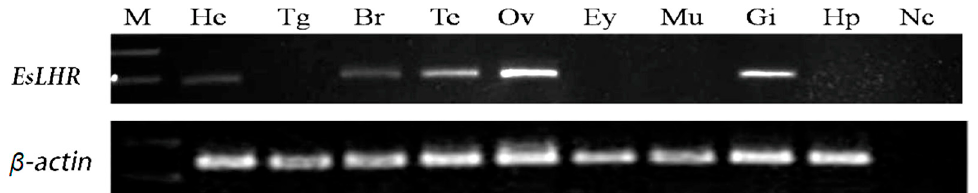
Figure 4. RT-PCR analysis of distribution of EsLHR mRNA in different tissues. M: marker; He: heart; Tg: thoracic ganglion; Br: brain; Te: testis; Ov: ovary; Ey: eye stalk; Mu: muscle; Gi: gill; Hp: hepatopancreas; Nc: negative control. Int. J. Mol. Sci. 2019 , 20 , x FOR PEER REVIEW